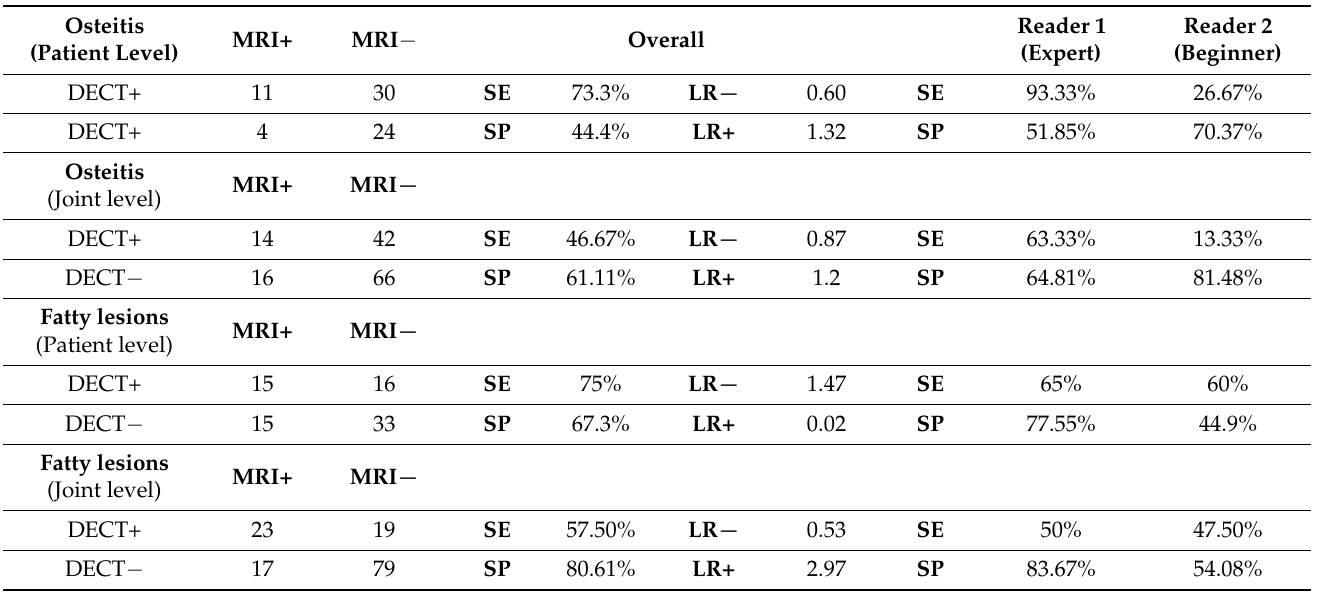
Table 1. Cross table, sensitivity (SE), specificity (SP), and positive and negative likelihood ratio (LR+/LR − ).Values are shown for osteitis and fatty bone marrow lesions on the patient level and on the joint level for both readers together and separately for the expert reader and the beginner scoring dual-energy CT (DECT) using MRI as gold standard. DECT scores show limited diagnostic accuracy for detection of both osteitis and fatty bone marrow deposition. The expert reader (Reader 1) with 13 years of experience in musculoskeletal imaging showed higher performance than the beginner (Reader 2), a research student with 3 years of